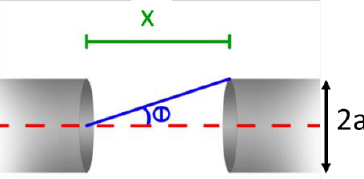
Figure 3. Schematic of two tubes separated by a distance x . The sound field included within the cone